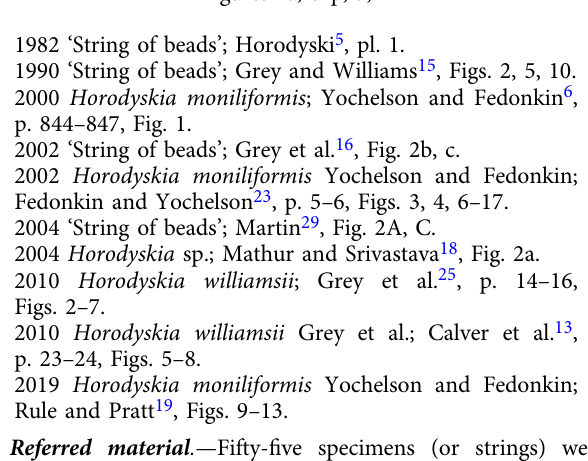
Fig. 2 Horodyskia moniliformis and Horodyskia minor from the Tonian Shiwangzhuang Formation. Most beads of H. moniliformis are enveloped in a halo. a A specimen of H. moniliformis with halos (red arrow) preserved together with several specimens of H. minor (white arrows) and carbonaceous fi laments (arrowheads) on a slab; SWZ-CZ-46. b Magni fi cation of box area in a ; arrows denote three strings of H. minor . c – e Specimens of H. moniliformis with halos (arrows); specimen in d possess beads with and without a halo (arrowheads); c SWZ-CZ-6; d SWZ-CZ-3; e SWZ-CZ-44; f H. moniliformis preserved together with H. minor (arrow); SWZ-CZ-53. g Magni fi cation of box area in f ; arrows denote boundary between halo and surrounding matrix, and arrowhead denotes boundary between halo and bead. h A specimen of H. moniliformis with halos; dotted line labeled “ j ” denotes location where the bead was cut perpendicular to bedding surface; SWZ-CZ-38. i Magni fi cation of box area in h ; arrows denote boundary between halos and beads, and arrowheads denote boundary between halos and surrounding matrix. j , k Top view ( j ) and side view ( k , polished slab) of bead cut along dotted line labeled “ j ” in h , with arrowheads denoting boundary between halo and surrounding matrix and matching those in h , and arrows denoting bead. l A specimen of H. moniliformis ; dotted line labeled “ n ” denotes location where the bead was cut perpendicular to bedding surface; SWZ-CZ-28. m Magni fi cation of box area in l ; uppermost bead with a halo (arrow) is still discernable after a layer of ca. 0.05-mm-thick sediment was removed, suggesting a degree of three- dimensional preservation. n – p Top view ( n ) and side view ( o , polished slab; p , thin section) of bead cut along dotted line labeled “ n ” in l ; arrowheads